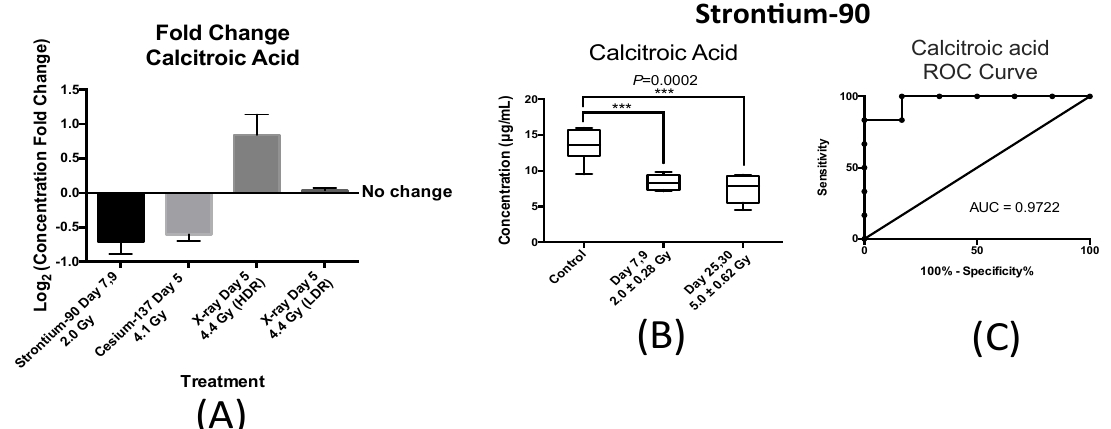
Figure 5. ( A ) changes in the urinary concentration of calcitroic acid from mice after various exposure types. The y -axis represents log 2 fold change after exposure and x -axis represents each of the three exposure senarios; 90 Sr exposure at days 7–9 after exposure at cumulative dose of 2.0 Gy, 137 Cs at day 5 after exposure at cumulative dose of 4.1 Gy, and X-ray at day 5 post 4.4 Gy exposure at high dose rate (HDR) of 1.1 Gy/min min and low dose rate (LDR) of 0.00309 Gy/min. 90 Sr and to a lesser extent 137 Cs exposure induced a decrease in the urinary levels of calcitroic acid, while X-ray exposure (HDR) had an opposite effect. No statistically significant change in the urinary concentration of calcitroic acid was detected after LDR exposure; ( B ) box plot representation of urinary concentration of calcitroic acid from mice after 90 Sr-exposure. The calculated mean ± SEM for the control mice was 13.6 ± 0.96 µg/mL, for days 7–9 at cumulative skeleton dose of 2.0 Gy was 8.4 ± 0.46 µg/mL, and for days 25–30 at 5.0 Gy was 7.5 ± 0.90 µg/mL. Each study group contained at least 6 samples; ( B ) concentration fold change was calculated by the log 2 ratio of urinary concentration of calcitroic acid in mice exposed to 90 Sr to that of calcitroic acid in control mice